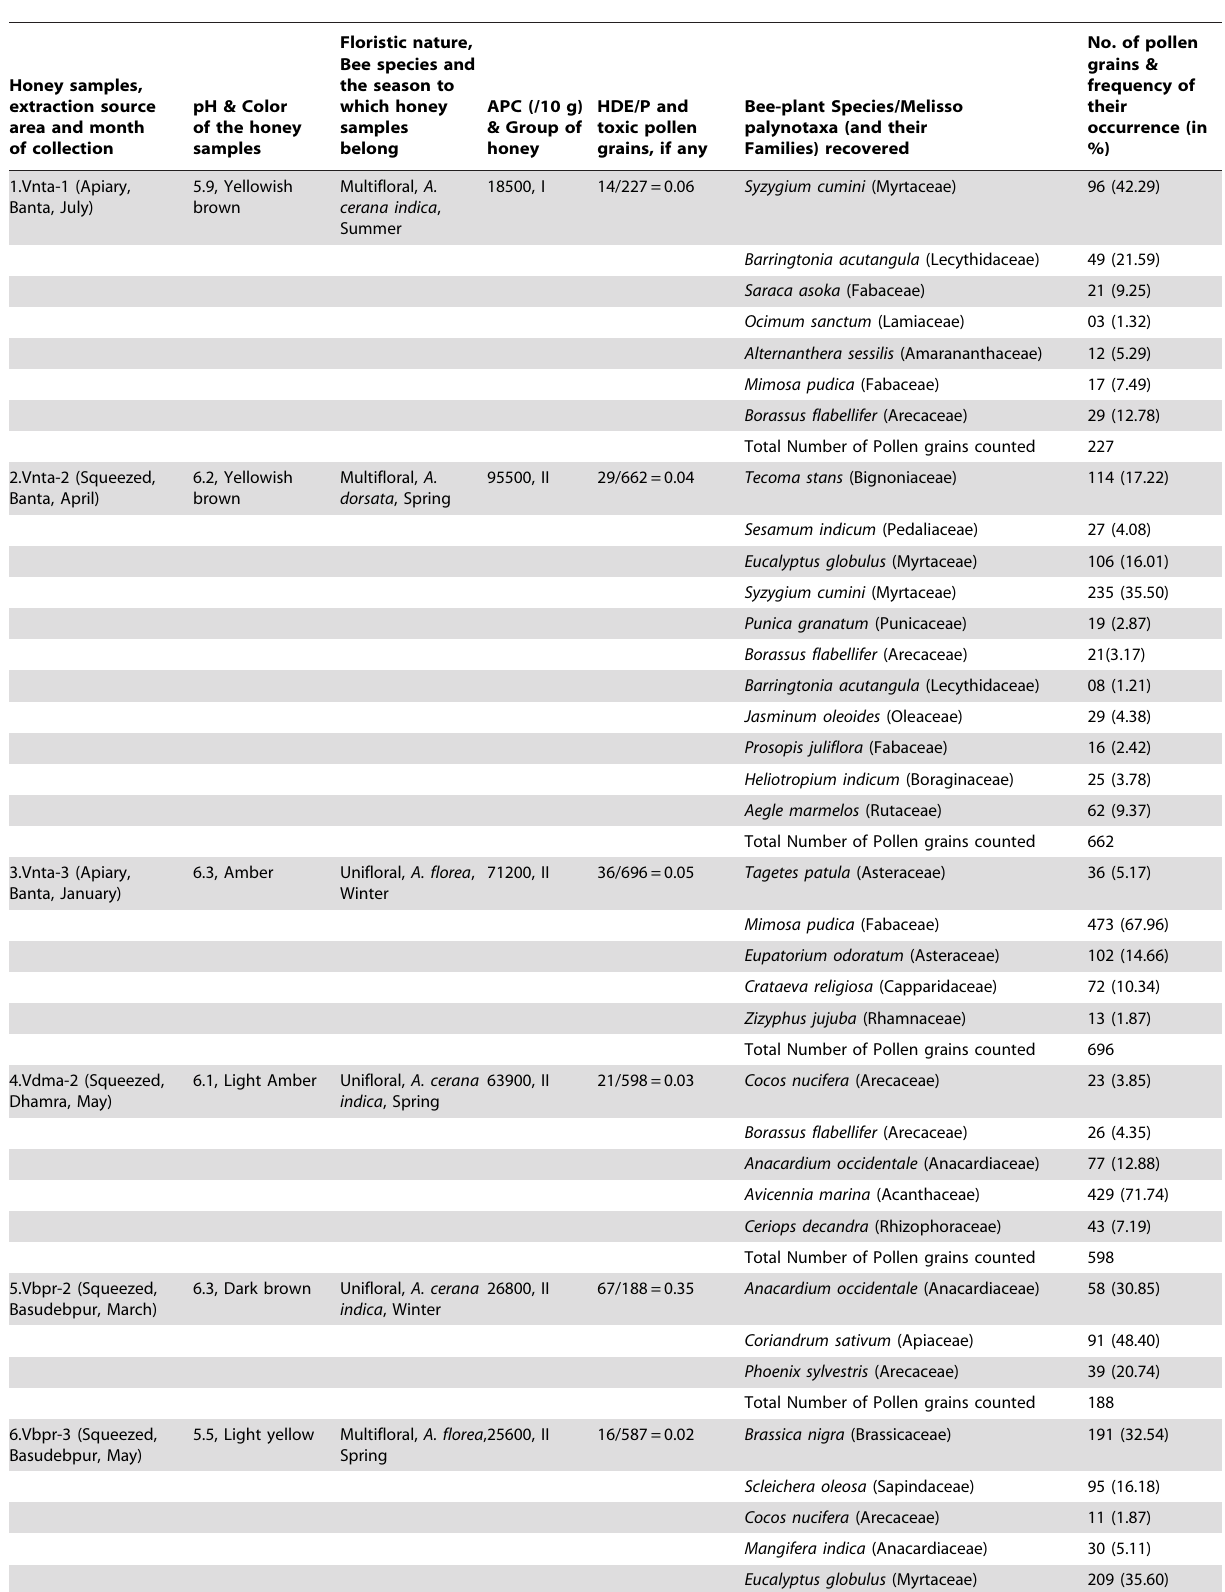
Table 1. Melissopalynological data of natural honey samples from two east-coastal districts of India.